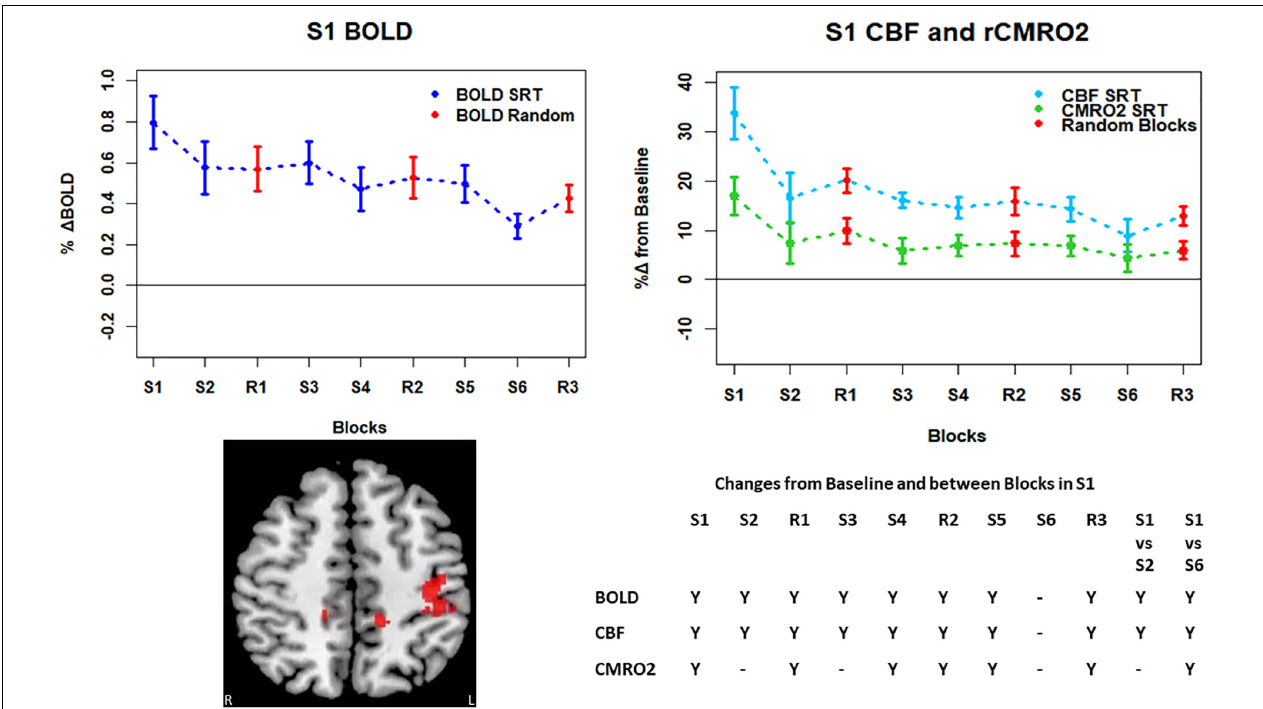
FIGURE 6 | Mean ± SEM SRT task responses in S1. Plots show a mean reduction in BOLD and CBF across task blocks. S1 = SRT block 1, R1 = random block 1. Y = Yes to indicate statistically significant ( p < 0.05), signal changes from baseline and between first and second and first and last SRT blocks. BOLD and CBF showed significant increases from baseline across all sequence and pseudorandom task blocks, except S6. There were also significant reductions in BOLD and CBF between sequence blocks S1 and S2 and S1 and S6. There was a sustained CMRO 2 increase across all random blocks and the first, fourth and fifth sequence blocks but CMRO 2 was not different from baseline in the second, third or final sequence blocks. As in M1, there was only a significant difference between S1 and S6 in CMRO 2